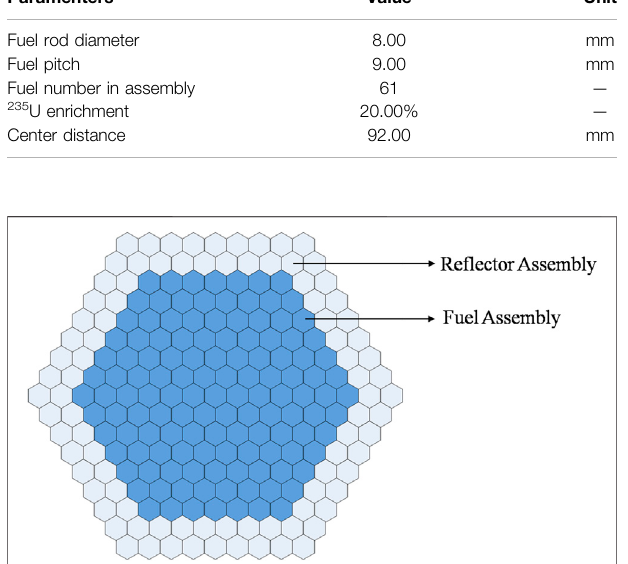
FIGURE 2 | The standard S-CO 2 assembly arrangement scheme.